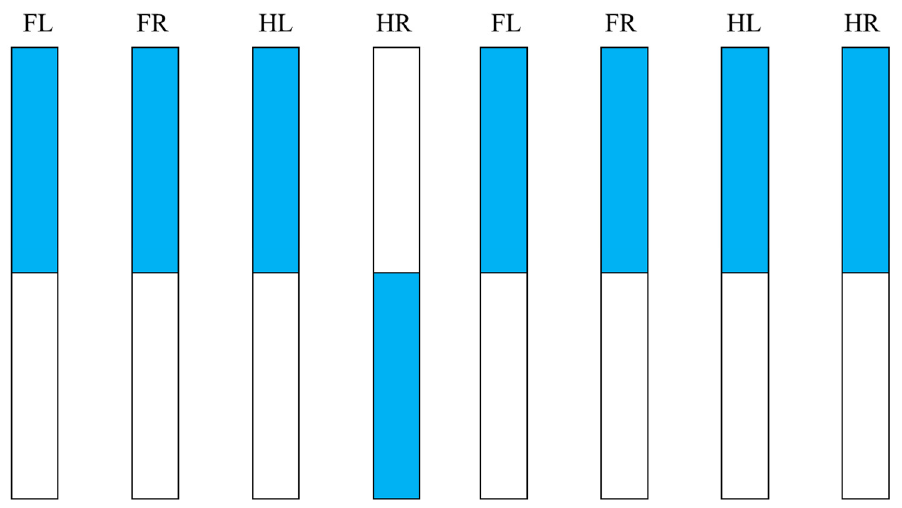
Figure 1. Schematic diagram of crawl.